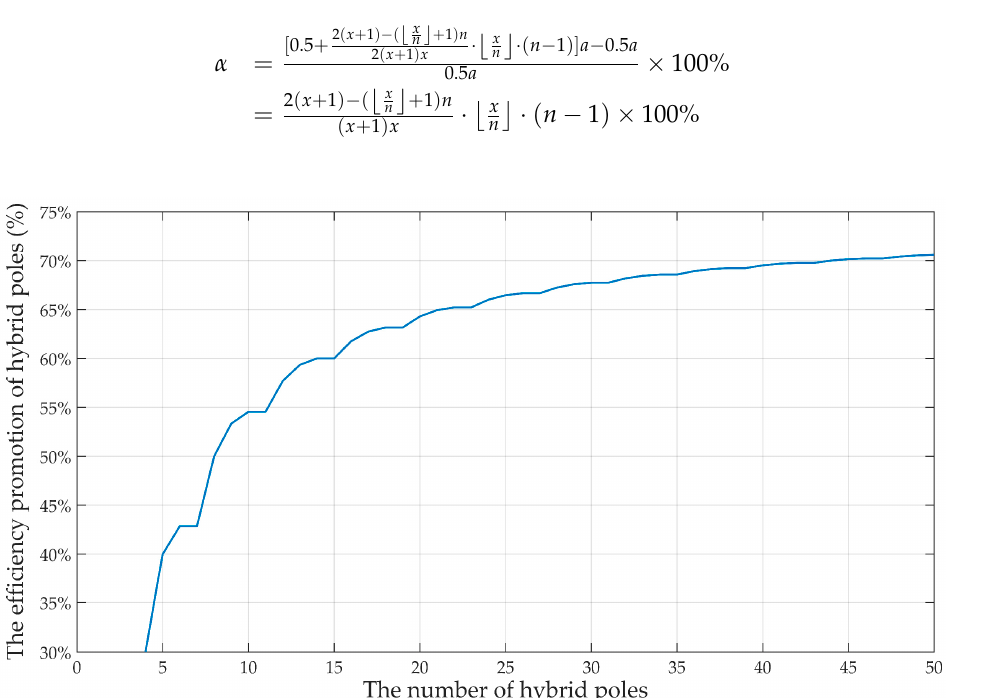
Figure 9. The functional image of the efficiency promotion of hybrid poles relative to traditional poles under uniform distribution. under uniform